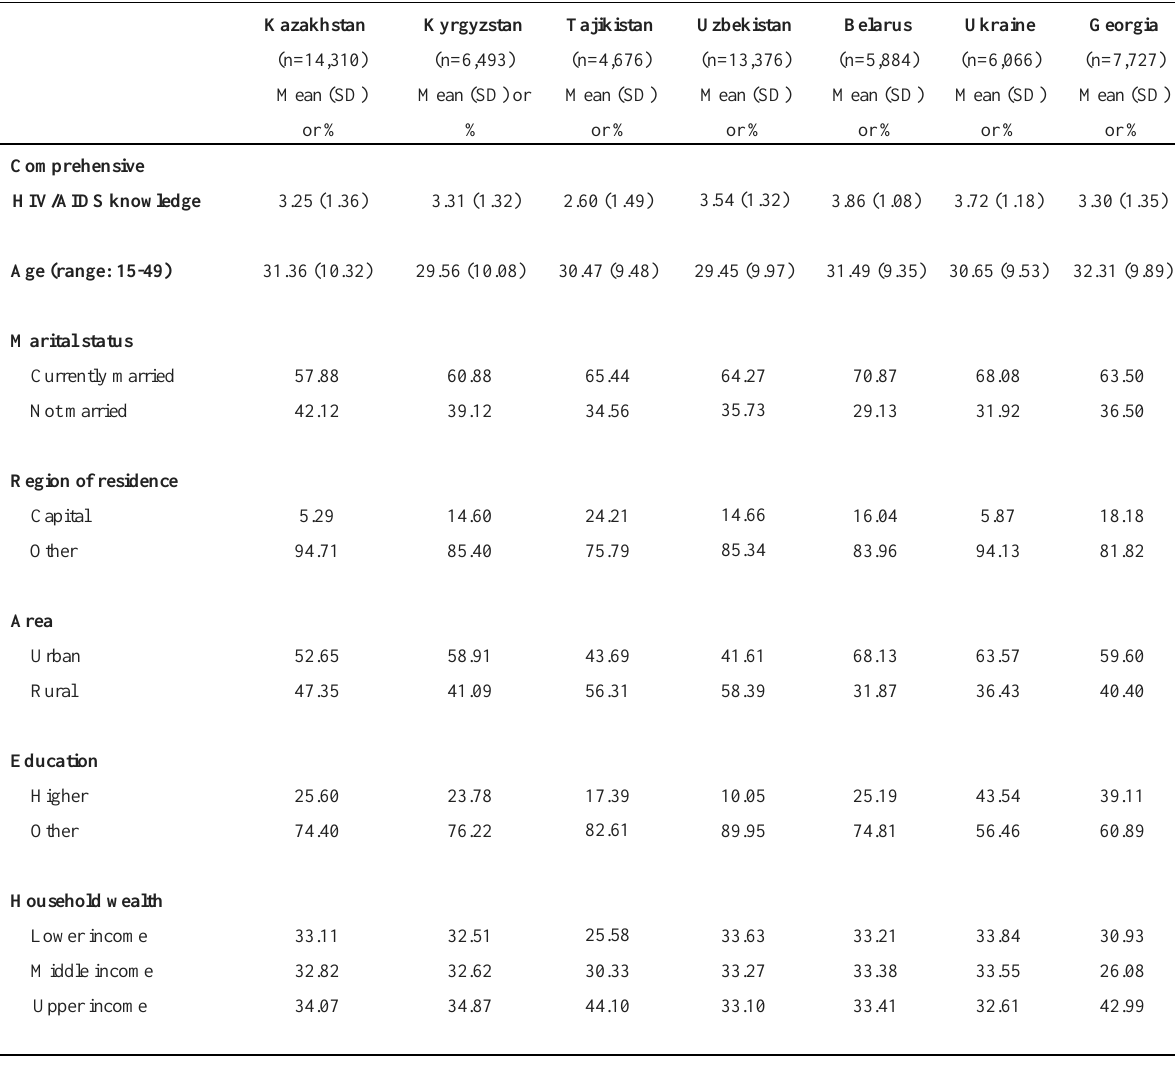
Table 1. Descriptive Statistics for the Sample Except for Uzbekistan and Tajikistan (43.69%), the majority of respondents in other countries resided in urban areas. Women in Uzbekistan (10.05%) and Tajikistan (17.39%) comprised the lowest percentage of respondents with higher (university/institute graduate) levels of education, whereas women in Georgia (39.11%) and Ukraine (43.54%) had the highest percentage. The